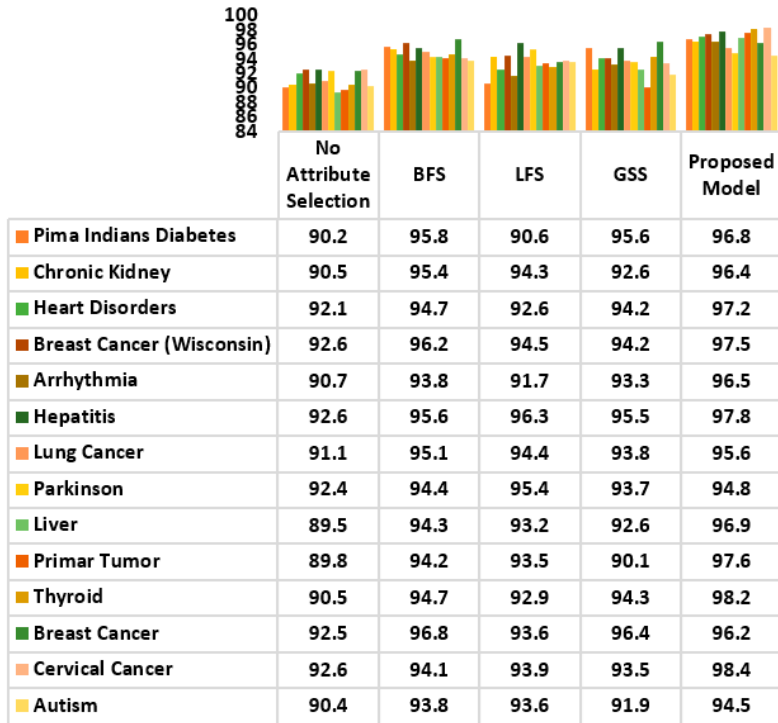
Figure 19. Comparative Study of the Classification Accuracy of the Proposed Attribute Evaluator Method and Other Wrapper Methods.